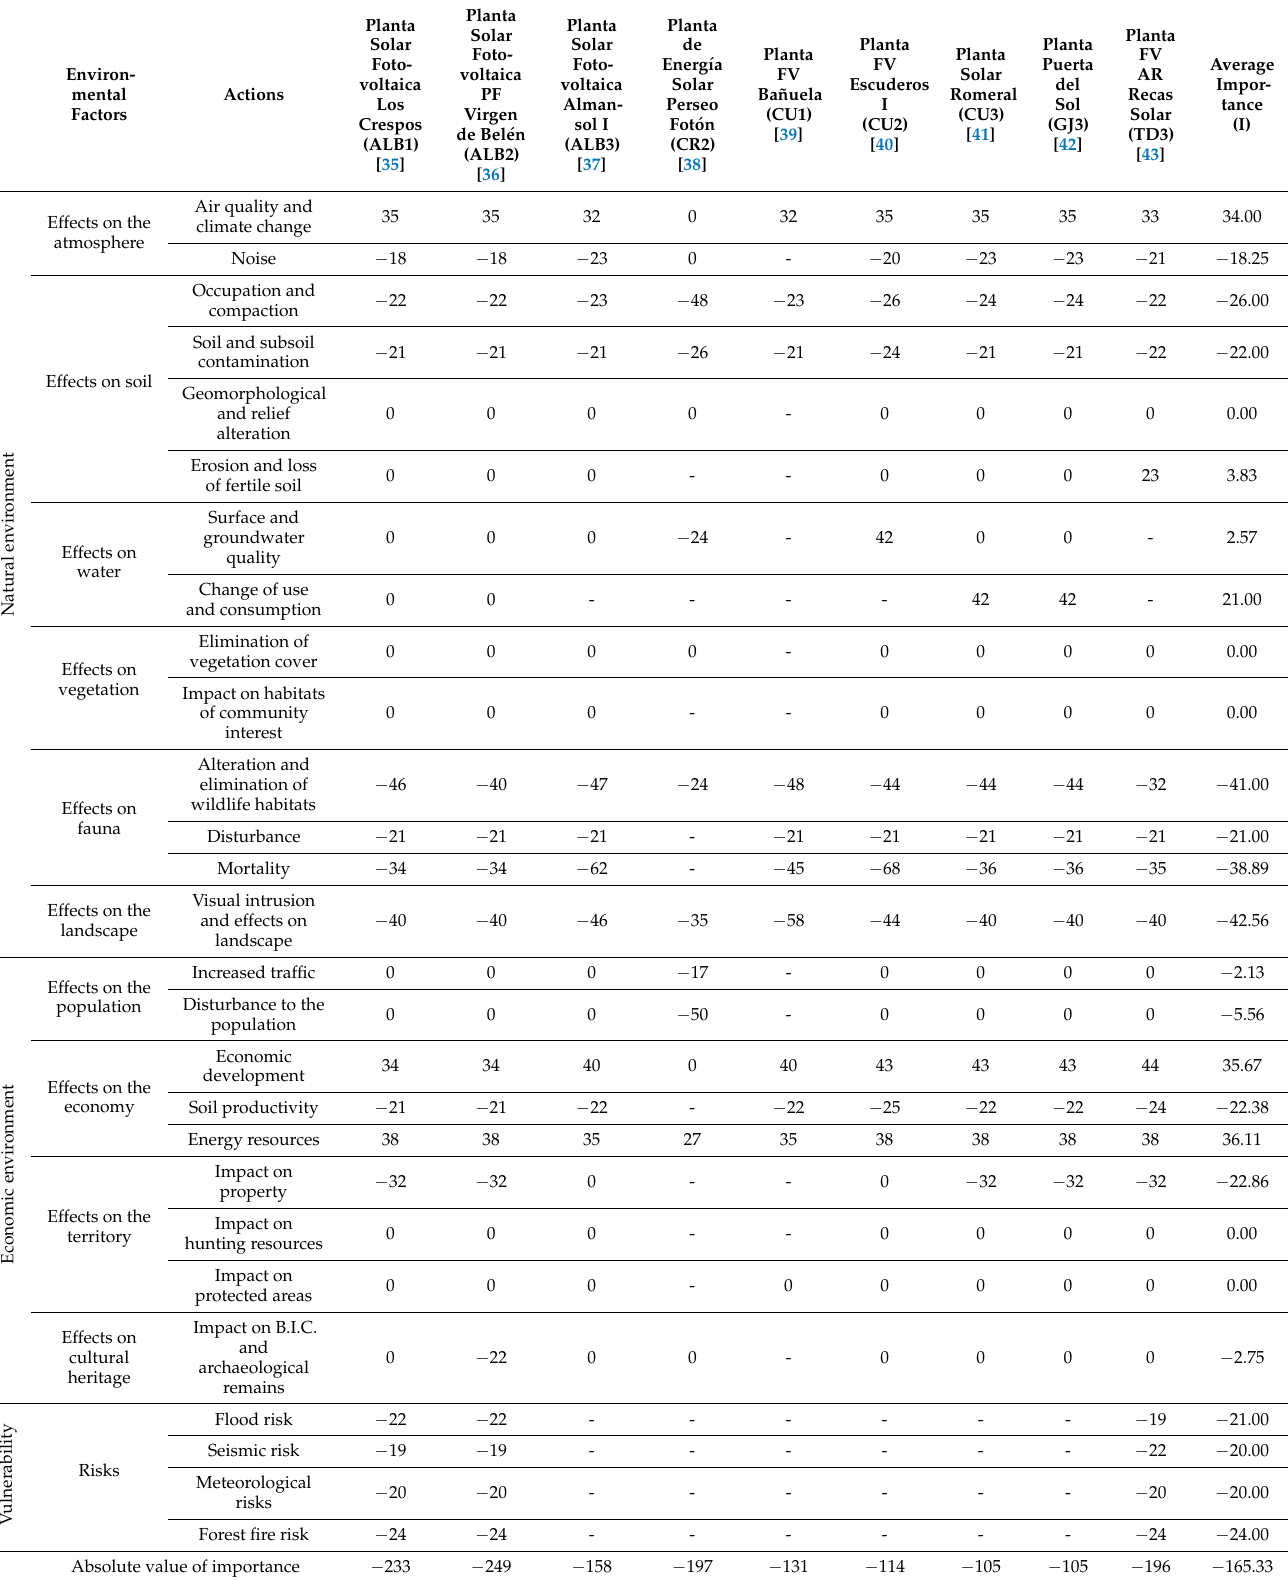
Table A5. Synthesis of the different importance matrix conducted in the selected PV plants (opera- tion